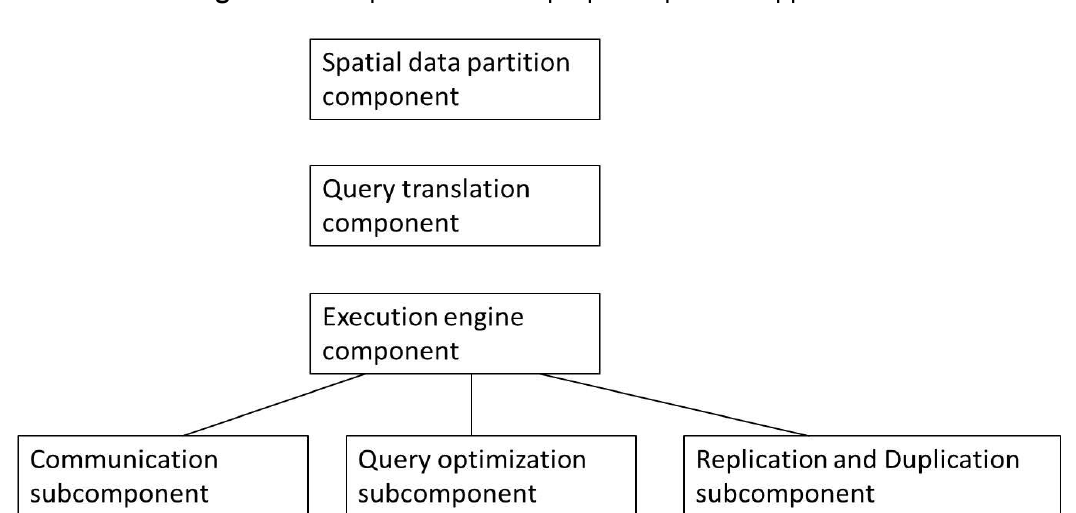
Figure 2. Components of the proposed parallel